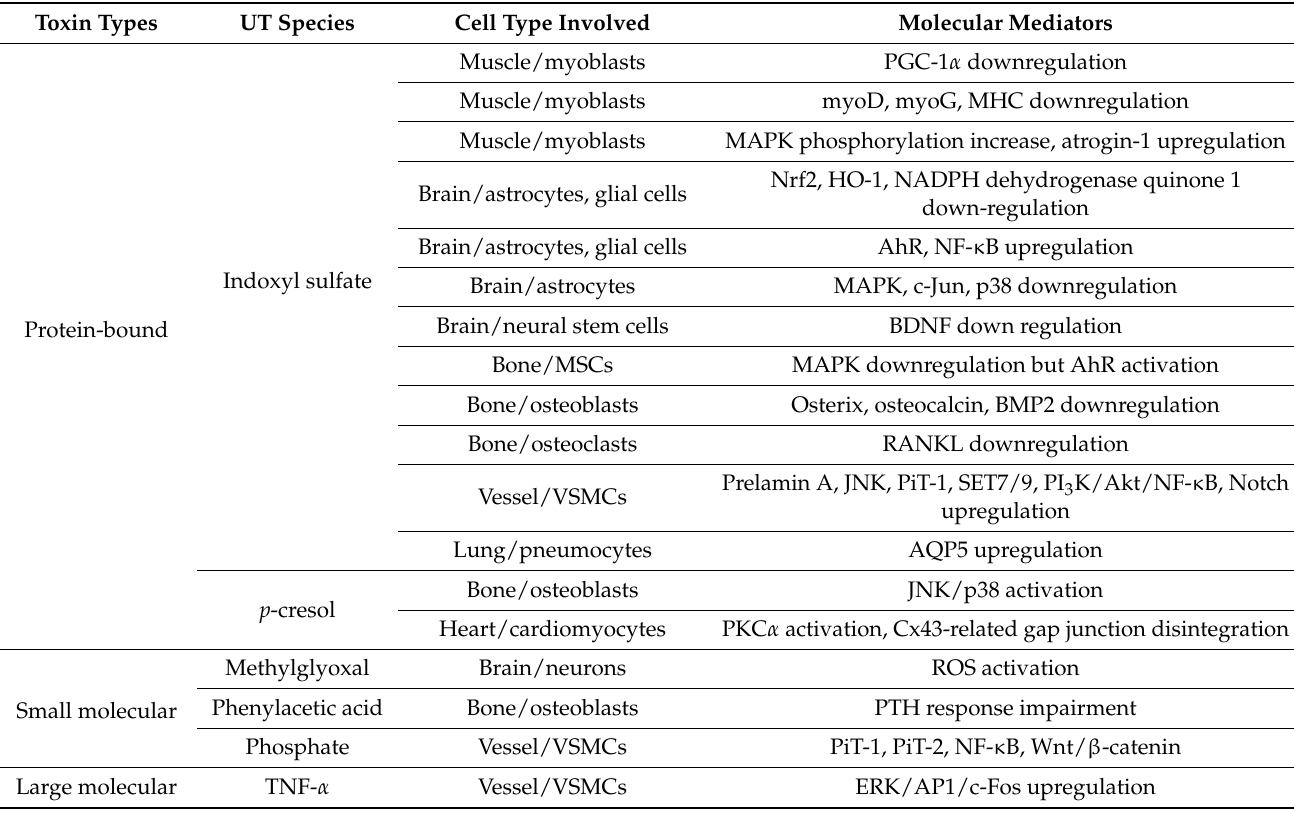
Table 2. Experimental findings connecting uremic toxins to frailty pathogenesis based on different cell